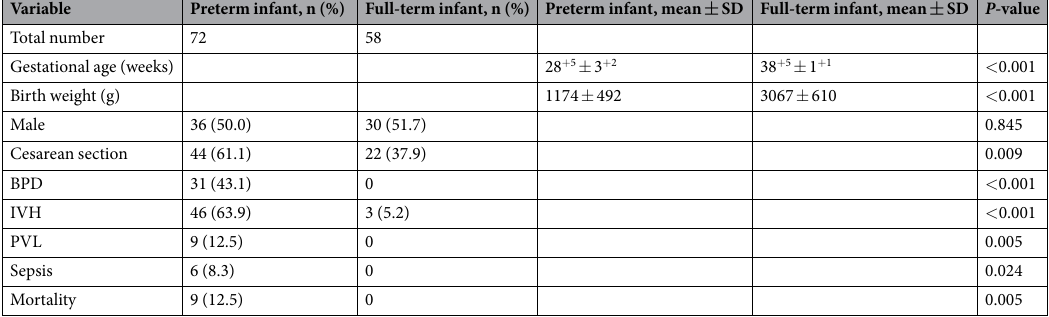
Table 1. Demographic data of study population. BPD, bronchopulmonary dysplasia; IVH, intraventricular hemorrhage; PVL, periventricular leukomalacia. n,